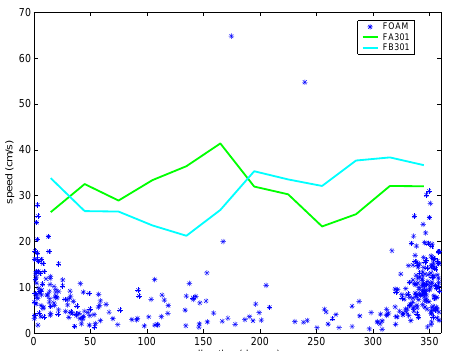
Fig. 14. Direction against model current speed at location corre- sponding to VEINS FA/FB, 301m depth. The 0.95 quantiles used as thresholds were computed from the observational data at site FA 301m depth (green) and at site FB 301m depth